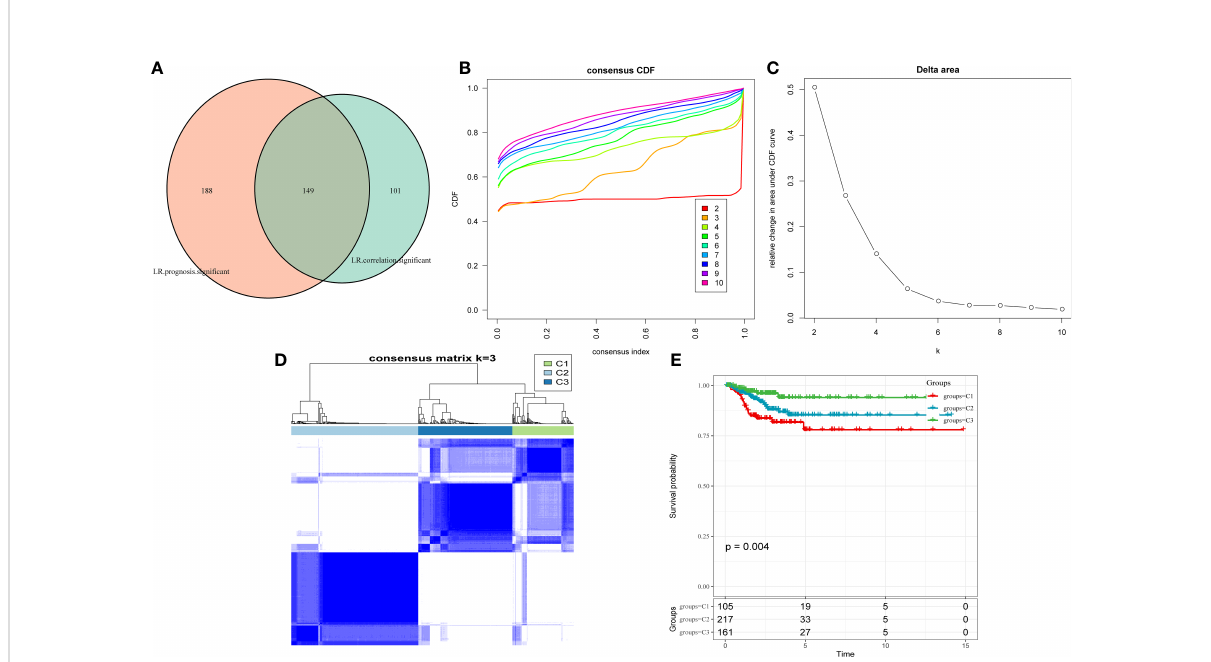
FIGURE 3 (A) Venn diagram of LR pairs with signi fi cant expression and prognosis correlation. (B) CDF curve of samples from TCGA cohort. (C) Delta area curve of samples from TCGA cohort. (D) TCGA clustering heatmap of samples from TCGA cohort when consensus k = 3. (E) Overall survival curves of molecular subtypes based on LR pairs. LR, ligand – receptor; CDF, cumulative distribution function; TCGA, The Cancer Genome